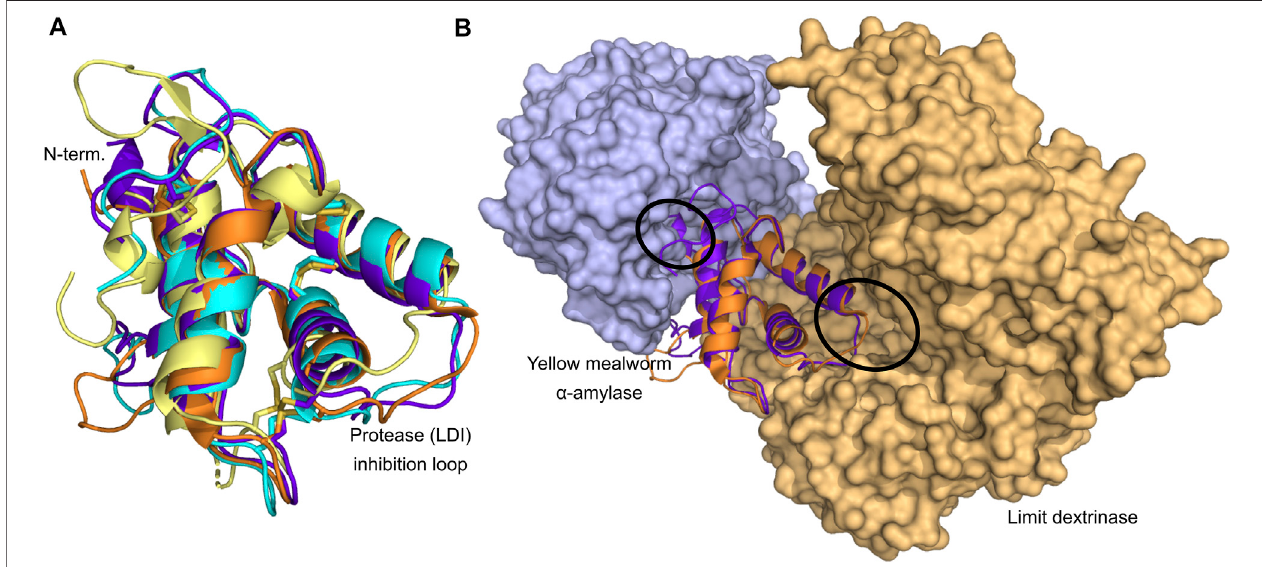
FIGURE 2 | Structure determined CTIs. (A) Structural superposition of the four structure determined CTIs; LDI (orange; PDB entry 4CWV), RBI (purple; PDB entry 1TMQ), CHFI (cyan; PDB entry 1BEA), and 0.19 (yellow; PDB entry 1HSS). Disul fi de bonds are shown as sticks. (B) Comparison of the inhibitor orientation of the two available CTI – enzyme complexes. LDI (orange; PDB entry 4CWV) and RBI (purple; PDB entry 1TMQ) are superposed revealing that opposite sides of the inhibitors are involved in the inhibition. The active sites of the enzymes are encircled. Structures were retrieved from the Protein Data Bank (PDB;